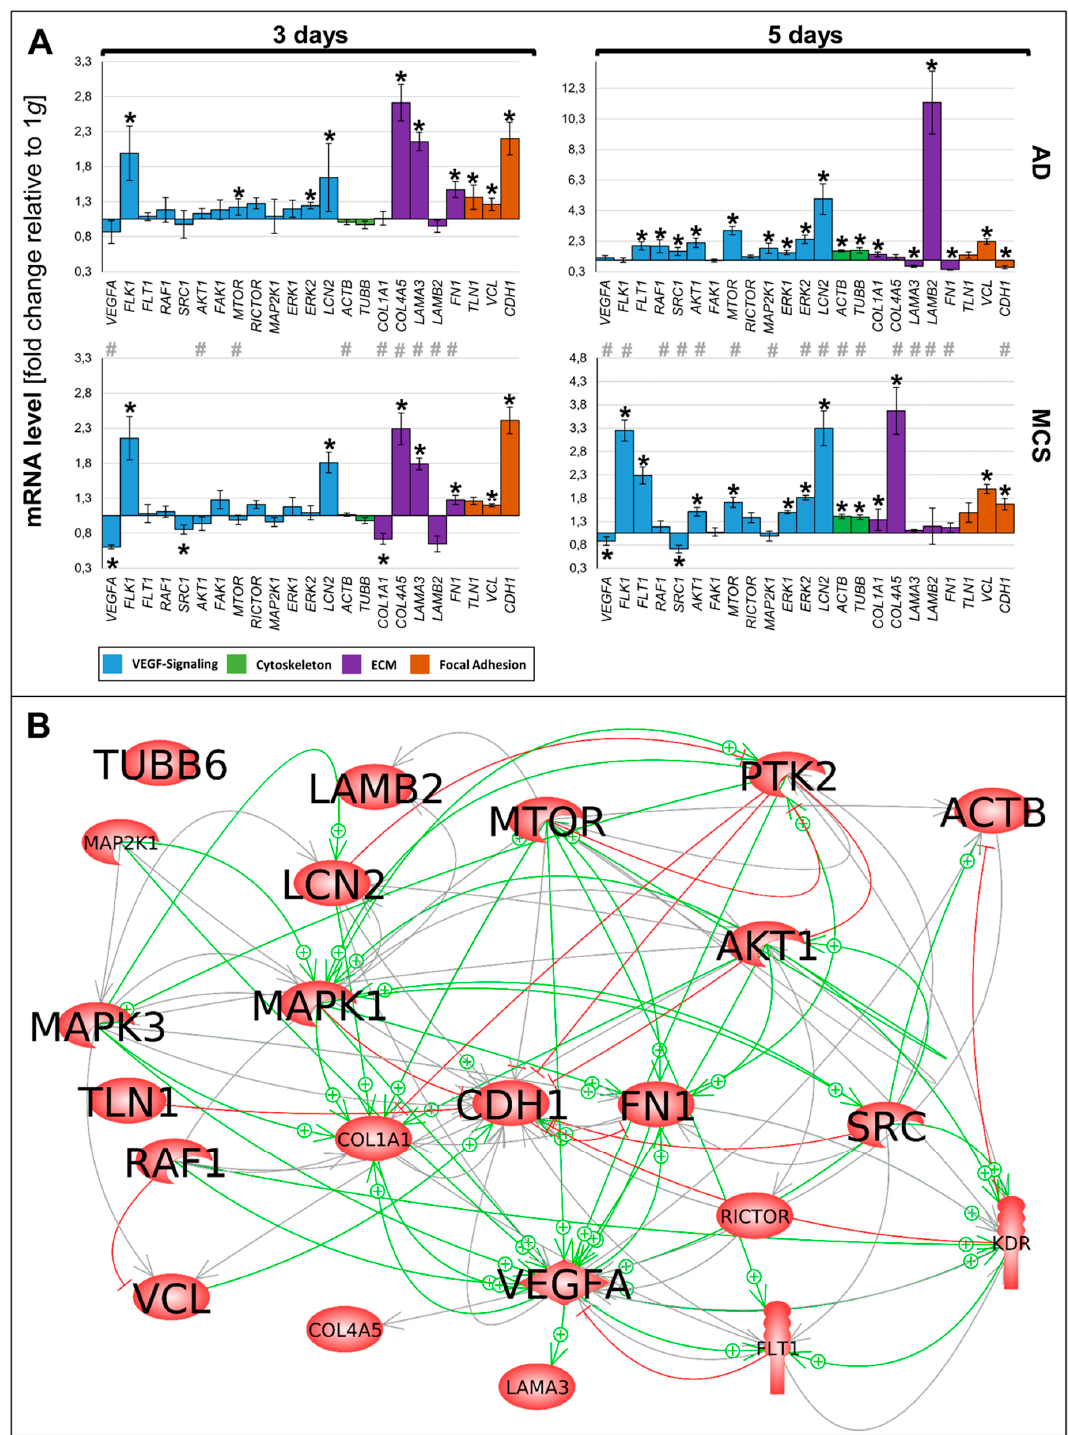
Figure 6. ( A ) Summary of gene expression fold change measured by qPCR of 3- and 5-day RPM-exposed PC-3 samples. Results determined in AD and MCS in relation to 1 g are shown. Color-coded bars represent genes of related biological processes. * p < 0.01 1 g vs. AD/MCS, # p < 0.01 AD vs. MCS. ( B ) Interaction network of selected items at gene expression level; 22 of 23 selected genes analyzed by qPCR contribute to the network comprising 114 relations. Green arrows indicate activation and red arrows indicate inhibition. Gray lines signify that interactions take place whose e ff ects have not been clarified. The interaction network was built using Elsevier Pathway Studio